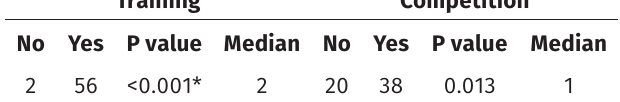
Table 3. Racket Sport Coaches Responses to the Use of IMUs and Number of Units in Training and Competition (* Significance of p<0.05). Training